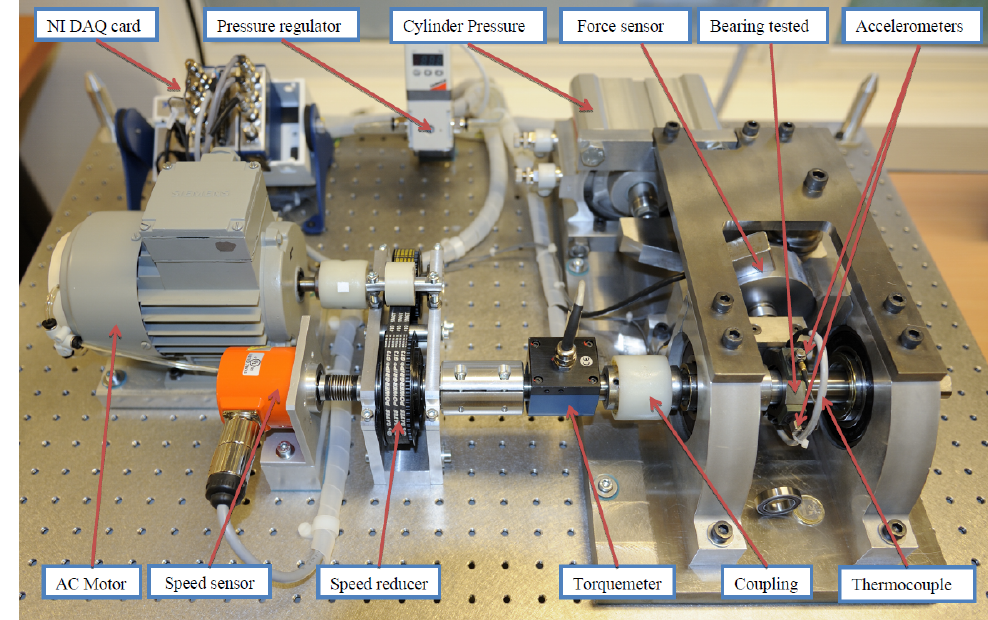
Figure 4. The testbed of bearing degradation experiment.